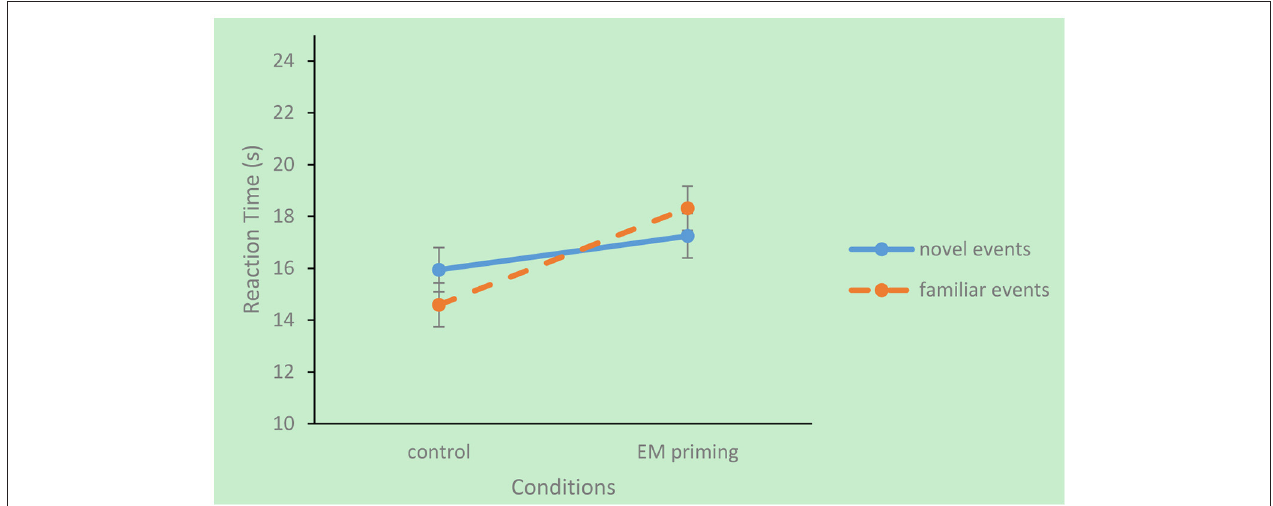
FIGURE 1 | The interaction effect of familiarity and priming condition on reaction